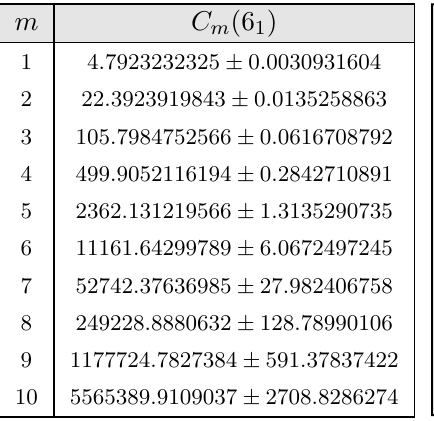
Table 10. Values of C m (6 1 ) . Figure 16. Variation of ln C m (6 1 ) with m .